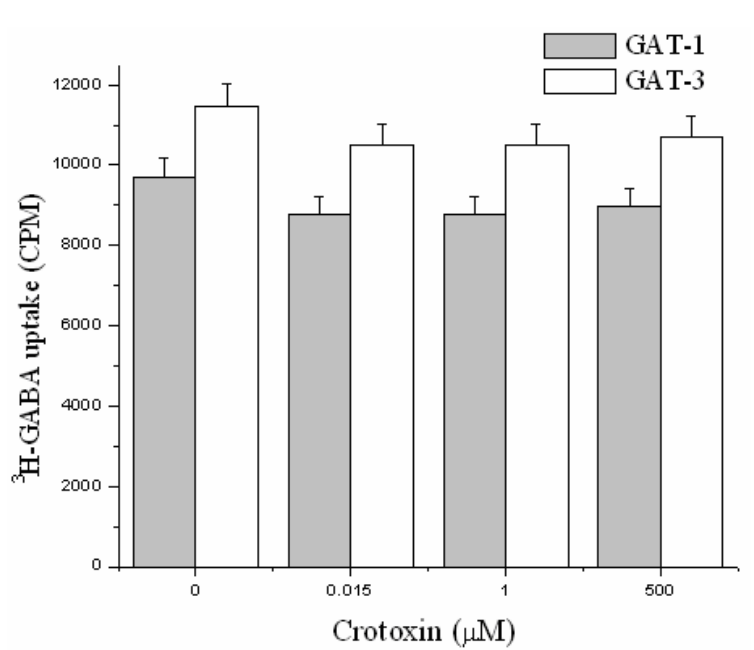
Figure 4. 3 H-GABA uptake by COS-7 cells expressing the gabaergic transporters GAT-1 and GAT-3. After incubation of crotoxin at different concentrations for 20 min, the neurotransmitter uptake was assayed. Both for GAT-1 and GAT-3, there was no significant inhibition of 3 H-GABA uptake (n=3).